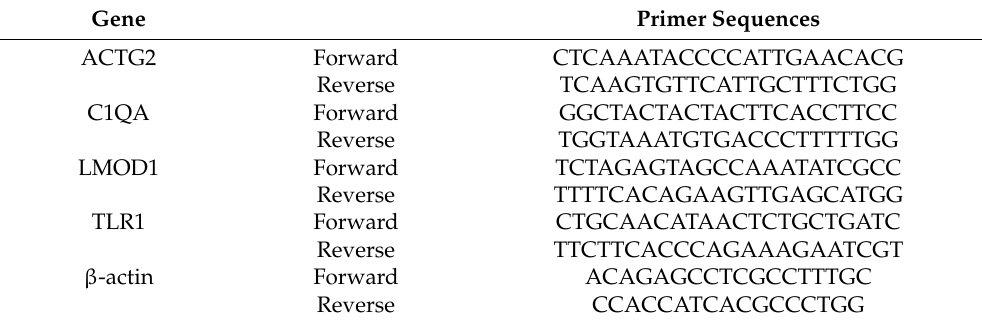
Table 1. Sequences used for